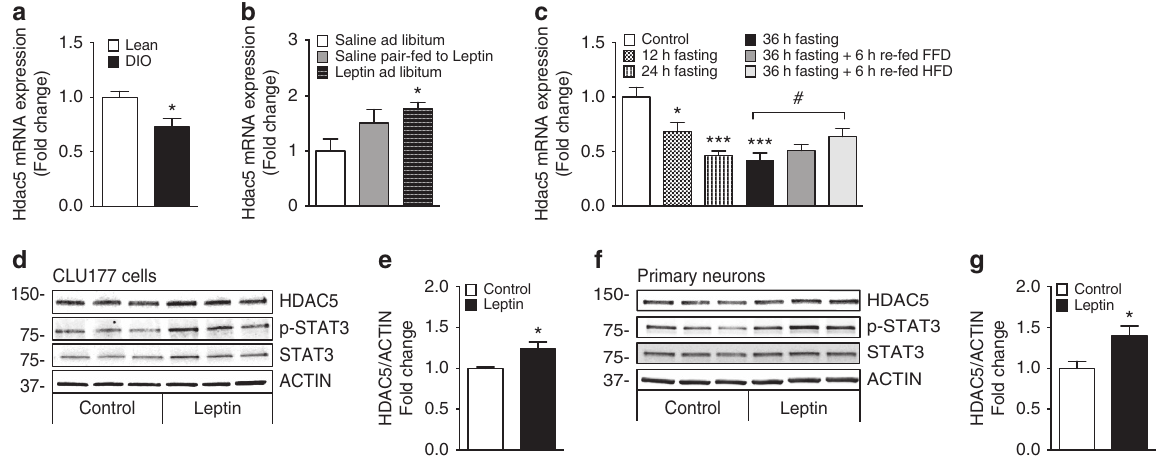
Figure 1 | Hypothalamic histone deacetylase 5 (HDAC5) expression is regulated by nutrient availability and leptin sensitivity. Hypothalamic Hdac5 mRNA levels were assessed by real-time PCR in ( a ) lean versus diet-induced obese (DIO) male mice ( n ¼ 7) and ( b ) male Lep ob mice treated subcutaneously for 6 days with either saline or 1mgkg (cid:2) 1 leptin ( n ¼ 5–6). Saline-treated mice were fed ad libitum ( ad lib ) or pair-fed to the lower food consumption of the Leptin ad lib group. ( c ) Hypothalamic Hdac5 expression was assessed in male C57BL/6J mice that were subjected to 12, 24 or 36h of fasting as well as refeeding for 6h with fat-free diet (FFD) or high-fat diet (HFD; n ¼ 6–8). HDAC5, total STAT3, p-STAT3 and ACTIN immunoblots and densitometric analyses of HDAC5 /ACTIN ratios in CLU177 cells ( d , e ) and primary neurons ( f , g ) treated for 24h with leptin. Values are means ± s.e.m. Statistical analyses were done by two-tailed unpaired Student’s t -test ( a , e , g ) or by One-Way ANOVA followed by Bonferroni ( b ) or Dunnet ( c ) post hoc tests. * P o 0.05, ** P o 0.01 and *** P o 0.001 versus Control; # P o 0.05 versus 36-h